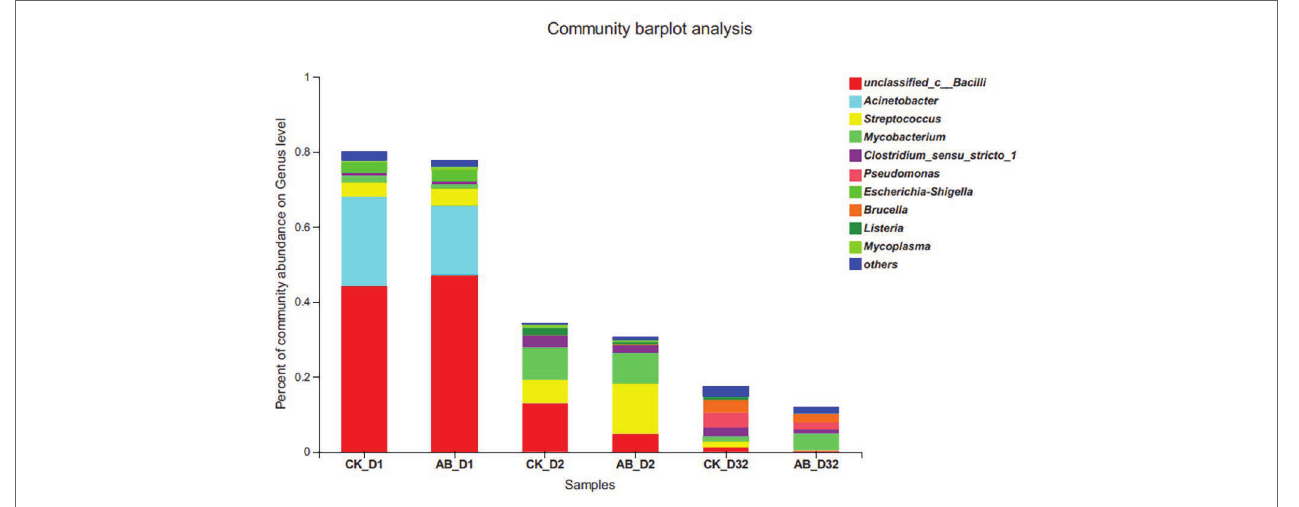
FIGURE 6 | Relative abundance changes of human pathogenic bacteria (HPB) during composting. CK: the swine manure composting. AB: add 1% compound microbial agents in the swine manure composting. D1 represents the mesophilic phase, D2 represents the thermophilic phase, and D32 represents the maturation